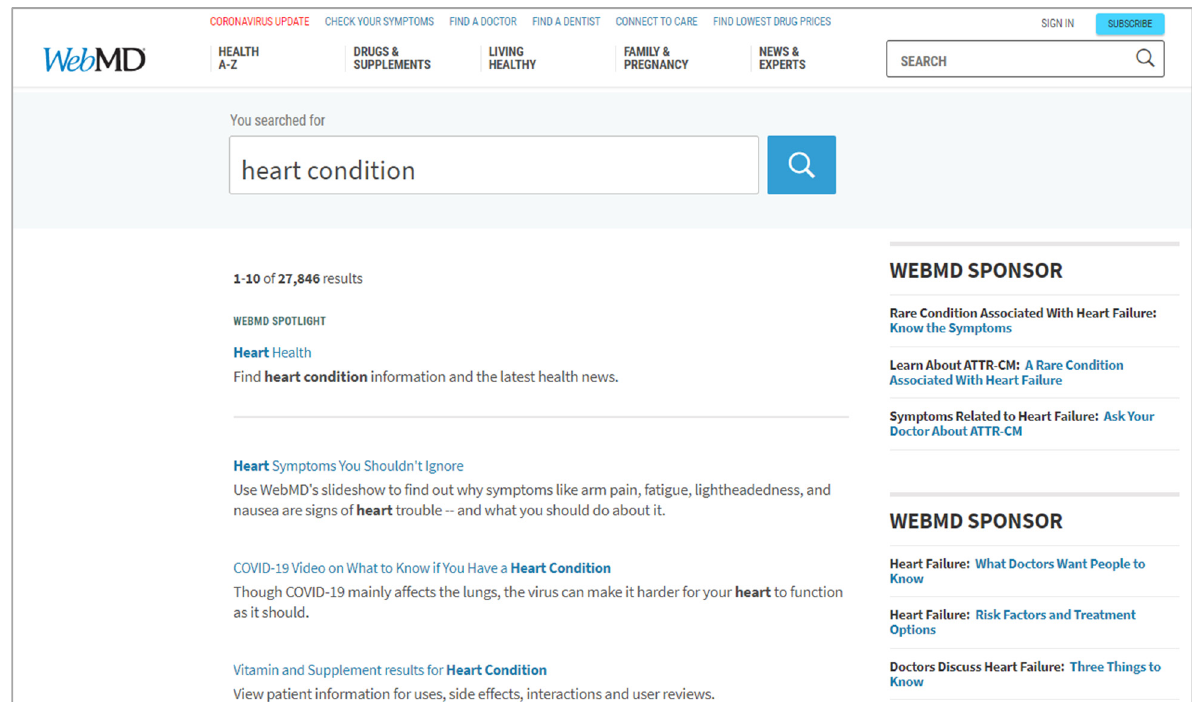
Figure 2. WebMD Search Interface: an example of an unstructured interface strategy for a search task. In this use case, the free – text query “heart condition” was generated. Source: Image generated on 18 January 2021, using the public web portal provided by WebMD, https://www.webmd.com/search/search_results/default.aspx?query=heart%20condition (accessed on 18 January 2021).